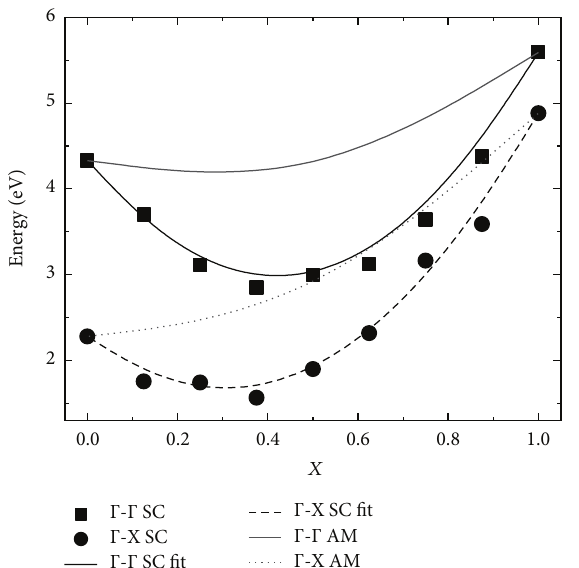
Figure 5: Composition dependence of different band gaps for the zinc-blendestructure(ZB).Filledpointsrepresentthesupercell(SC) alloy simulation with black lines representing their parabolic fit. Grey thin lines relate to the alchemical mixing (AM).